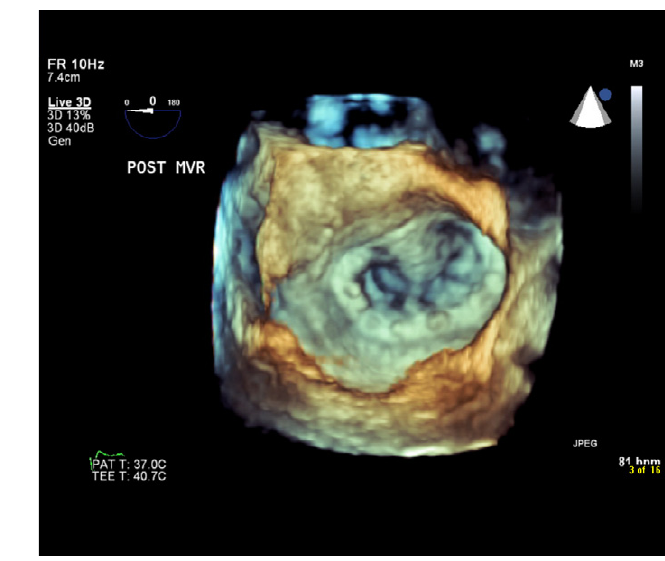
Figure. 8 3D echocardiograph image of annuloplasty band with closed leaflets in systole.